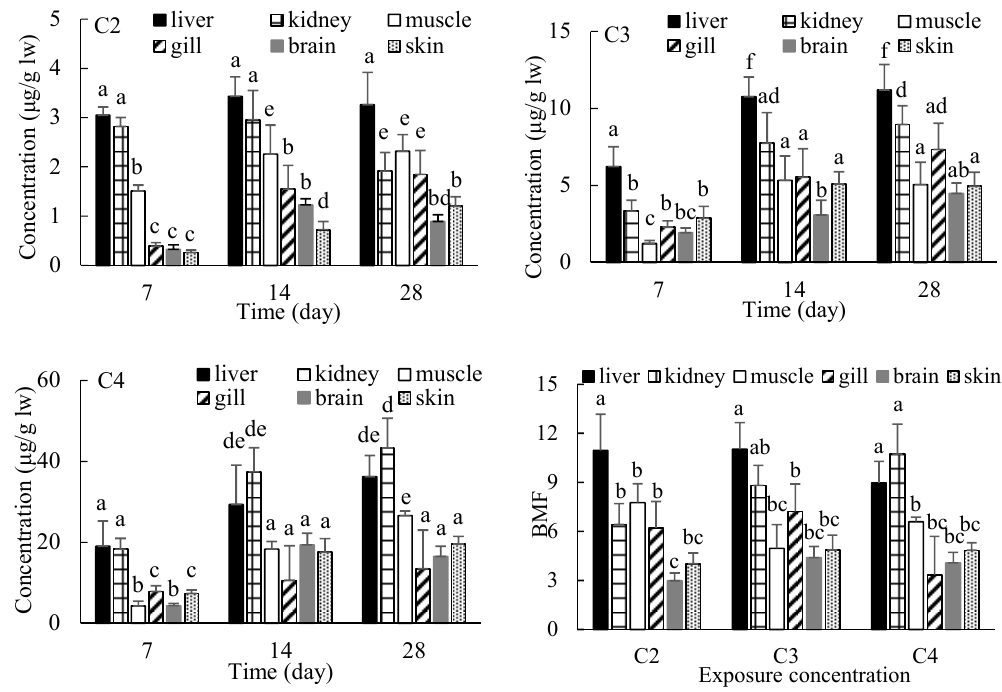
Figure 2. Concentrations and BMFs of EHDAB in different fish tissues by feeding exposure (C2, 0.2977 µ g/g lw; C3, 1.014 µ g/g lw; and C4, 4.033 µ g/g lw). Values are expressed as the mean ± standard deviation ( n = 3), and different letters above the bars indicate significant differences at the p < 0.05 level between treatments.